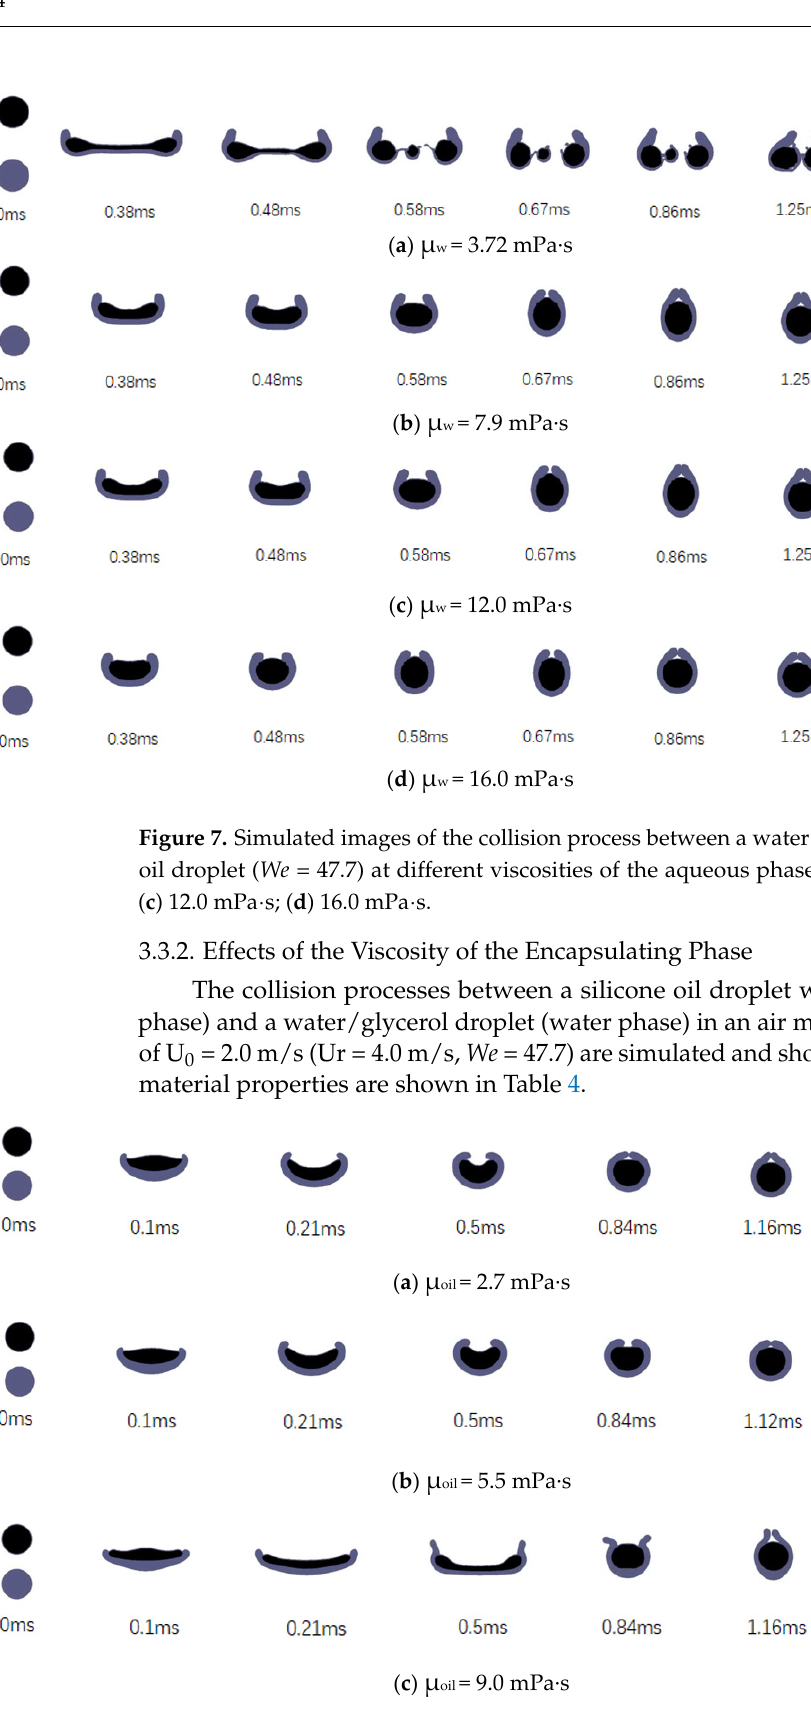
Figure 6. Simulated images of the collision process between a water/glycerol droplet and a silicone oil droplet ( We = 11.9) at different viscosities of the aqueous phase: ( a ) 3.72 mPa·s; ( b ) 7.9 mPa·s; ( c ) 12.0 mPa·s; ( d ) 16.0 mPa·s. Figure 7. Simulated images of the collision process between a water/glycerol droplet and a silicone oil droplet ( We = 47.7) at different viscosities of the aqueous phase: ( a ) 3.72 mPa·s; ( b ) 7.9 mPa·s; ( c ) 12.0 mPa·s; ( d ) 16.0 mPa·s.